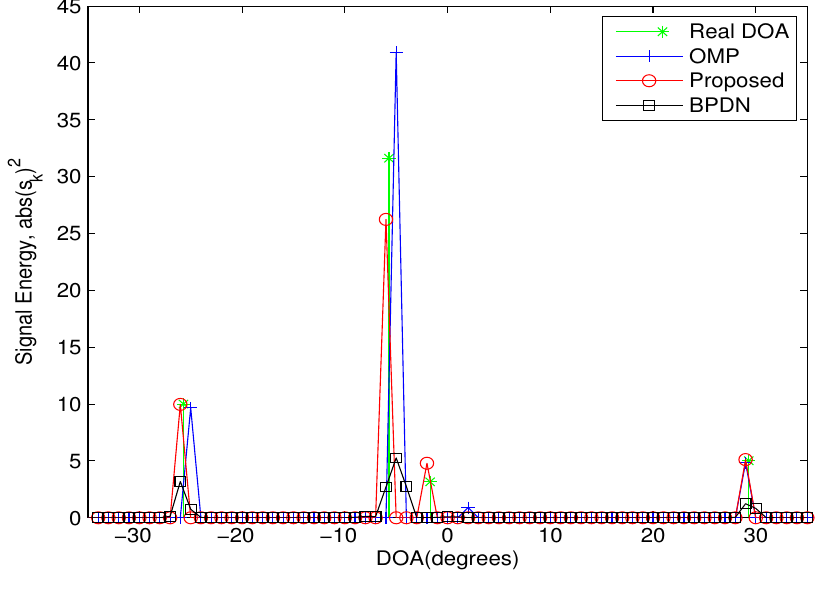
Figure 7. The performance comparison in the ideal case. Four sources are assumed from the DOAs {− 25 . 7 ◦ , − 5 . 7 ◦ , − 1 . 7 ◦ , 29 . 3 ◦ } . Four sources have different power, as 10 dB , 15 dB , 5 dB and 7 dB , respectively. The minimal DOA difference is 4 ◦ , and the grid spacing is 1 ◦ . The number of array elements is M = 12 , and the number of snapshots is one.